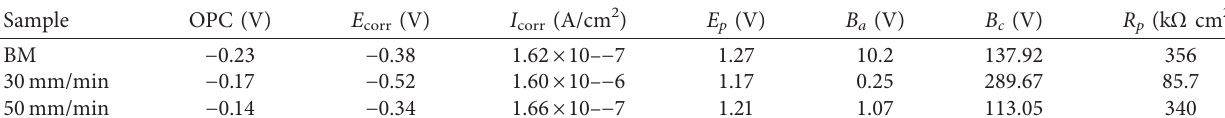
Figure 6: OPC and polarization curves of base material and stir zones obtained at different welding speeds: (a) OPC and (b) polarization curves. Table 2: Electrochemical corrosion parameters that resulted from analysis of OPC and polarization curves for specimens.